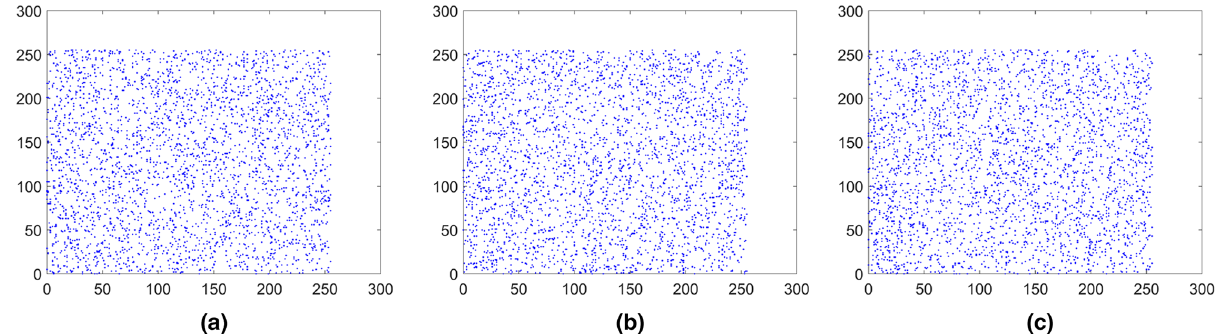
Figure 19. Distribution of adjacent pixels of the encrypted Binary_boat.512. ( a ) Horizontal direction of the encrypted image, ( b ) vertical direction of the encrypted image, ( c ) diagonal direction of the encrypted